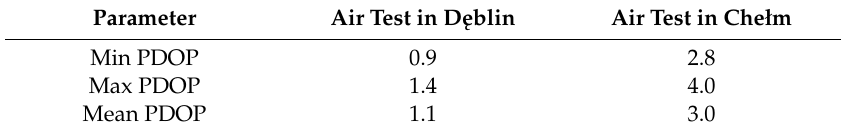
Table 7. The comparison of PDOP (Position Dilution of Precision) values in the air tests in D˛eblin and